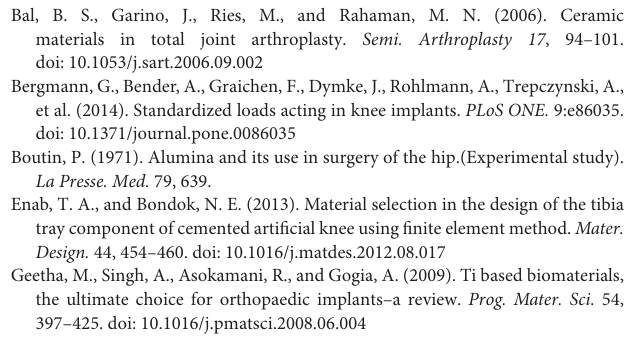
Table 4 , the stress values in bone tissues for all paths are higher when the zirconia-based FG biomaterial is employed. The largest differences are seen for paths 7 and